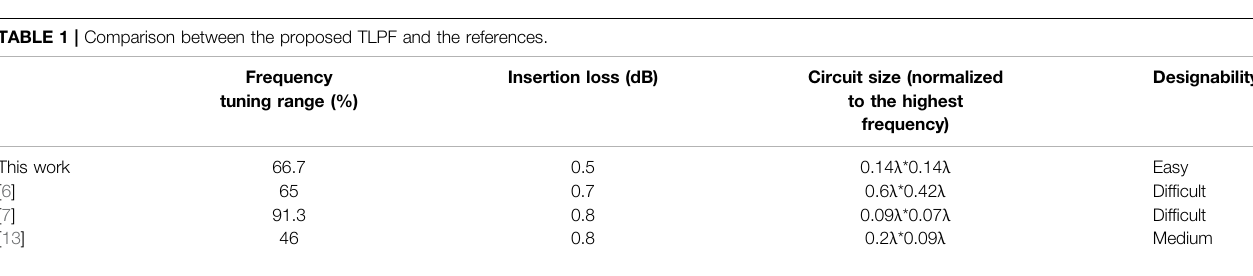
TABLE 1 | Comparison between the proposed TLPF and the